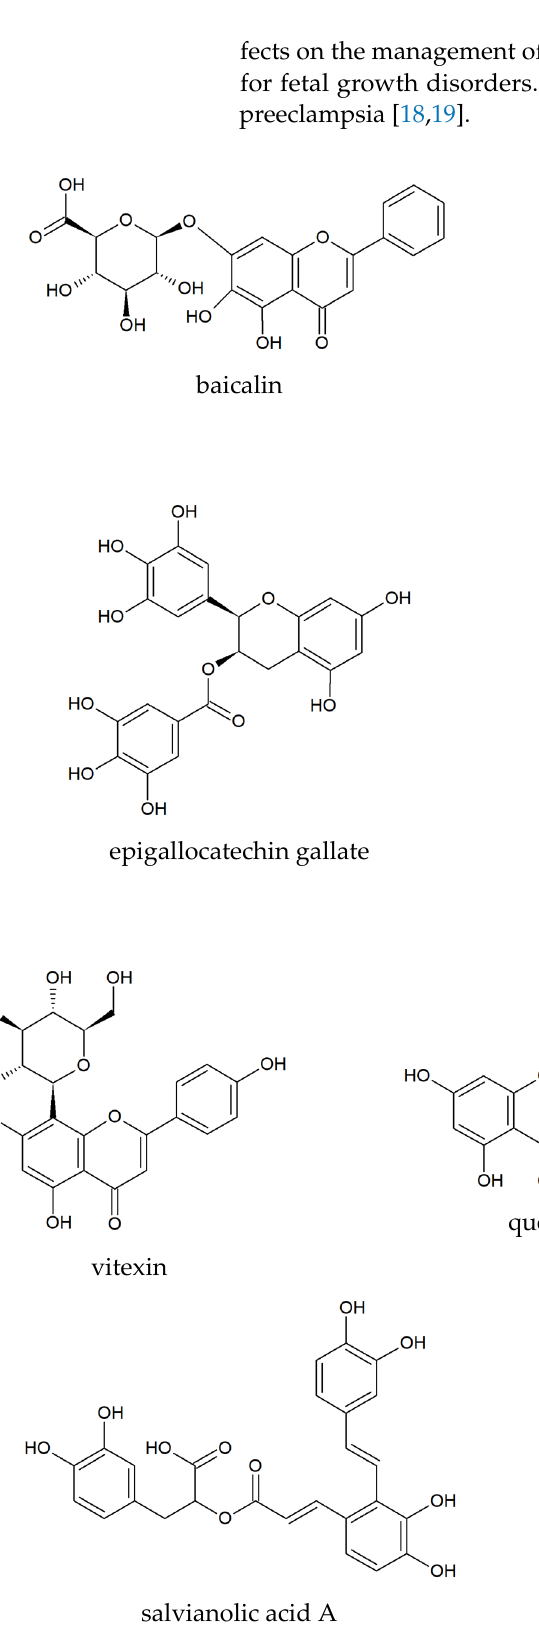
Figure 1. Chemical structures of polyphenolics.